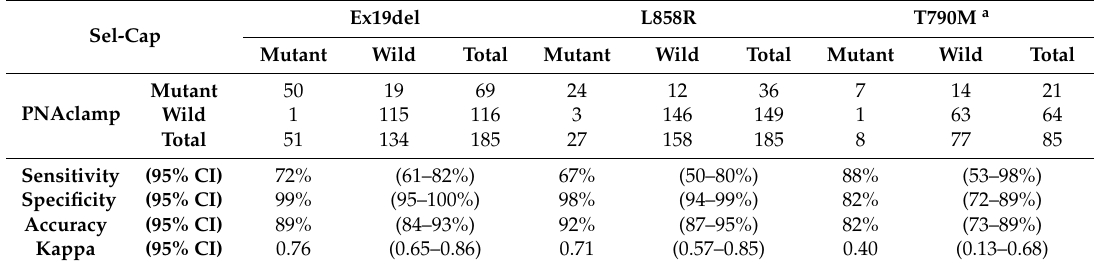
Table 2. Diagnostic performance of Sel-Cap liquid biopsy for three EGFR mutations in NSCLC patients (n = 185), regardless of disease stage, with PNAclamp tumor biopsy as the